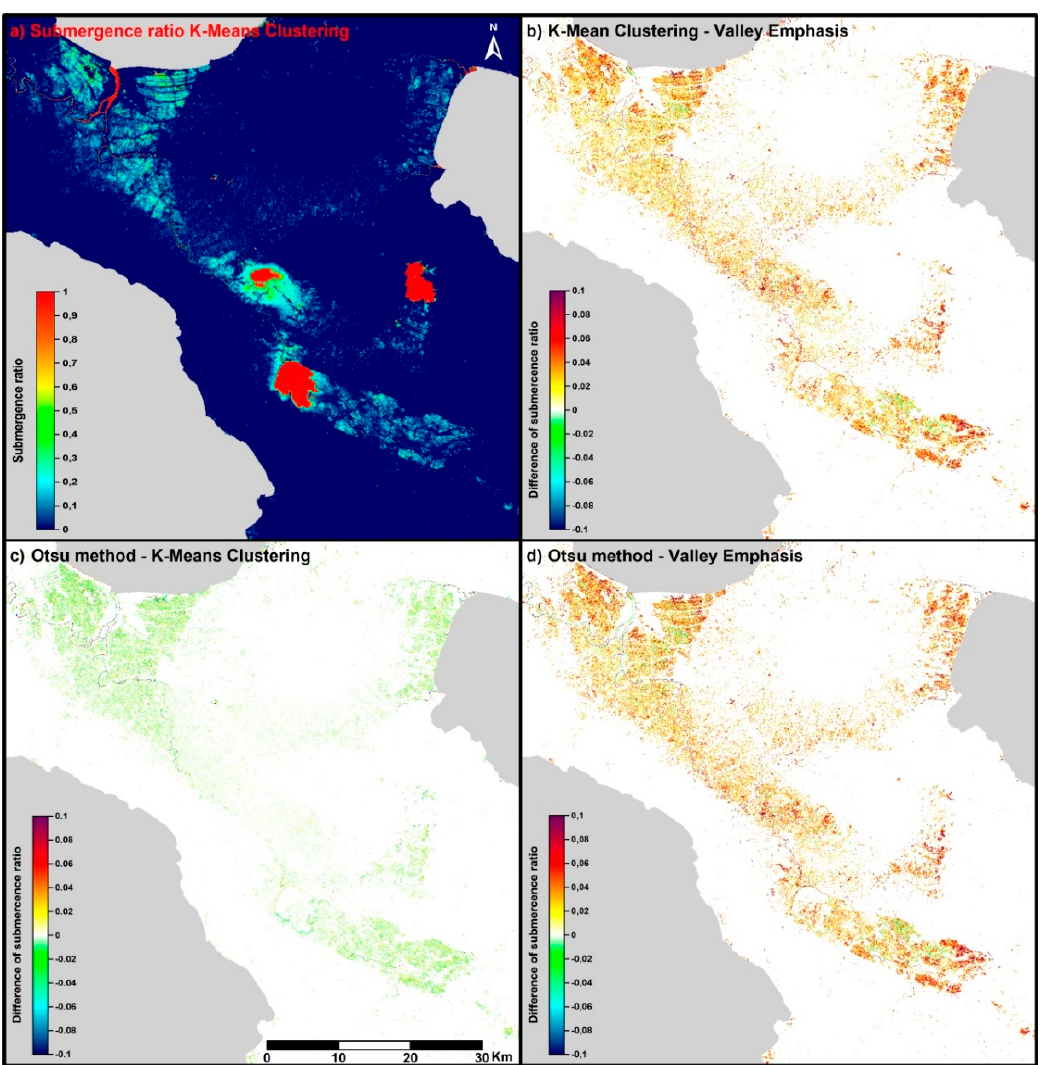
Figure 8. The map of ( a ) shows the submergence ratio (i.e., the flood persistence) in the reference period. A pixel value equal to 1 corresponds to an always flooded area. A value of 0 corresponds to a never flooded area. The maps of ( b – d ) are the differences in submergence ratios calculated using open water features extracted by different methods.